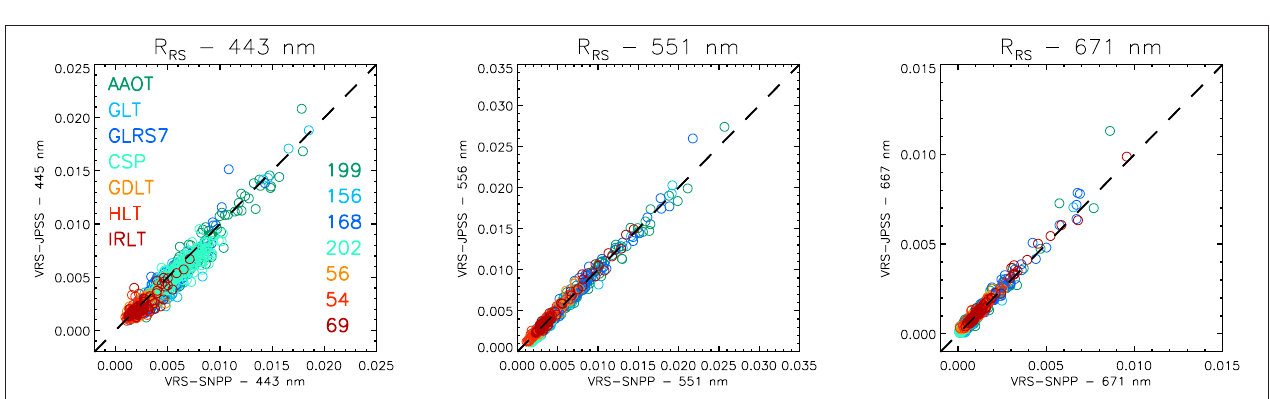
FIGURE 7 | Scatter plots of VIIRS-JPSS1 R RS data with respect to VIIRS-SNPP R RS at selected